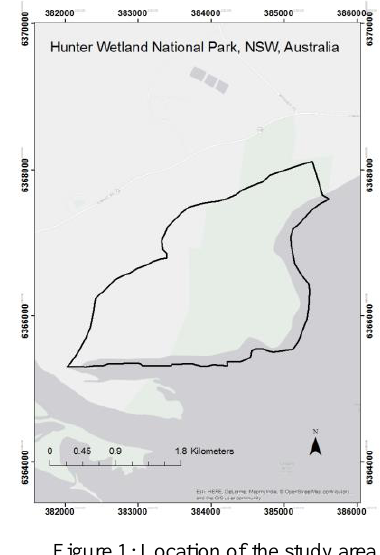
Figure 1: Location of the study